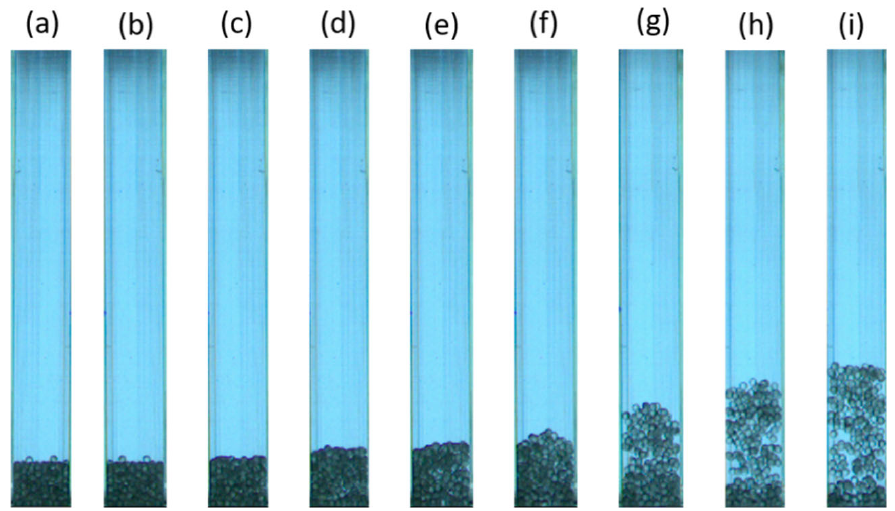
Figure 8. Fluidization regime changes with the increasing superficial liquid velocity in particles fluidization: ( a ) U L = 0 mm/s, ( b ) U L = 2.3 mm/s, ( c ) U L = 5.4 mm/s, ( d ) U L = 8.7 mm/s, ( e ) U L = 12.0 mm/s, ( f ) U L = 15.1 mm/s, ( g ) U L = 18.1 mm/s, ( h ) U L = 21.1 mm/s, ( i ) U L = 22.0 mm/s.